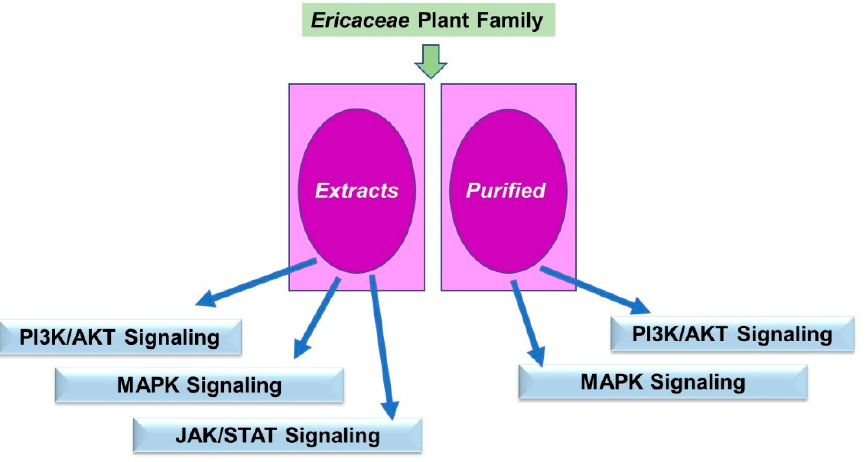
Figure 10. A schematic summary of the effects of metabolites from the Ericaceae on the MAPK, PI3K/AKT, and JAK/STAT signal transduction